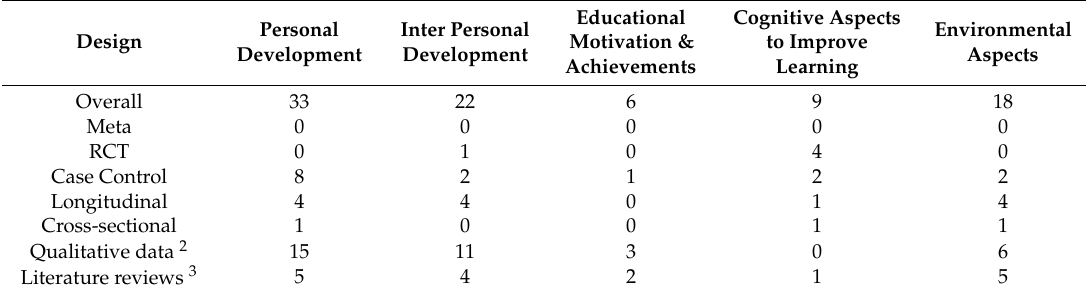
Table 6. Design of studies within educational impacts 1